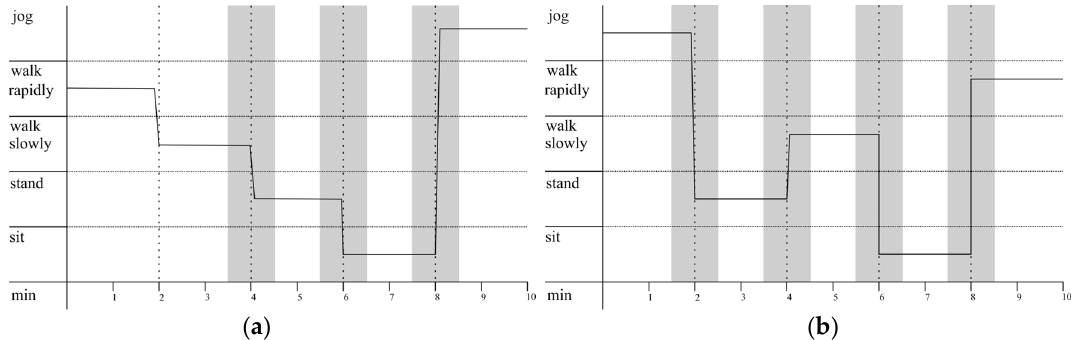
Figure 3. Laboratory part 2: Examples of two different possible activity protocols as a function of time. Thirty-second periods before and after posture changes within the laboratory part 2 are depicted as transition periods, illustrated by the gray areas. It becomes clear that the activity randomization for some participants yields three or fewer transitions ( a ), while for others it yields four transitions ( b ). The analysis of laboratory part 2 including all transition periods is referred to as laboratory part 2a and both, the white and the grey marked periods are analyzed. Laboratory part 2b refers to the same observation protocol with the transition periods excluded from the analysis.